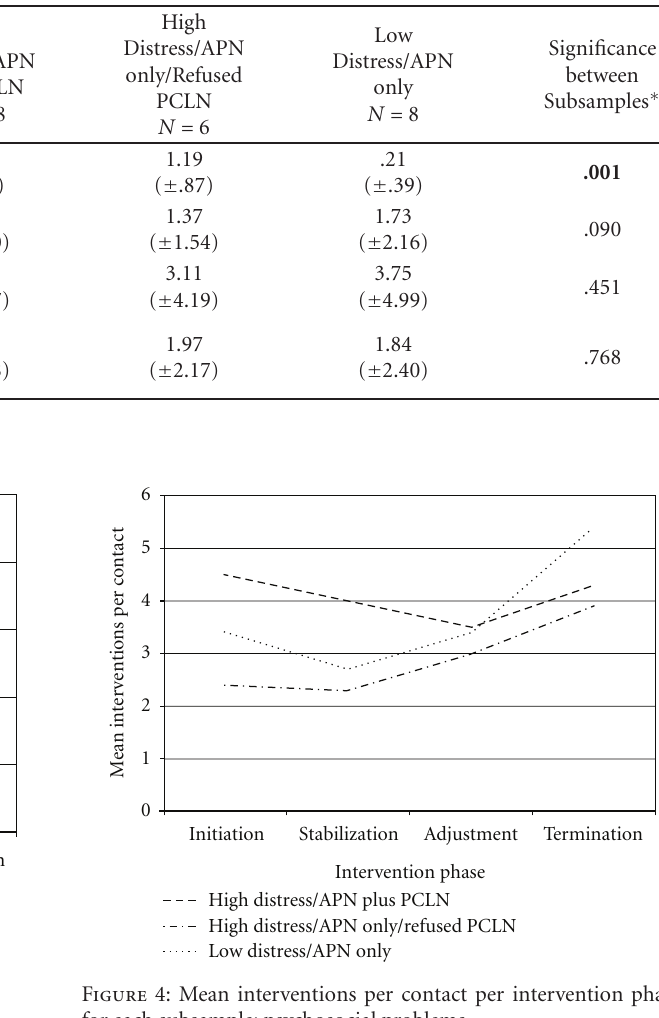
Figure 3: Mean Interventions per contact per intervention phase and subsample: all problems.